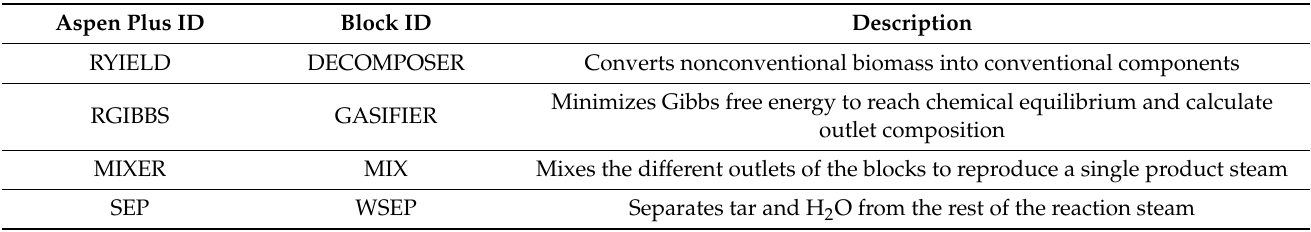
Figure 1. Comprehensive Aspen Plus flow sheet for the fluidized-bed air gasification. Table 5. Reactor models used in this simulation in Aspen